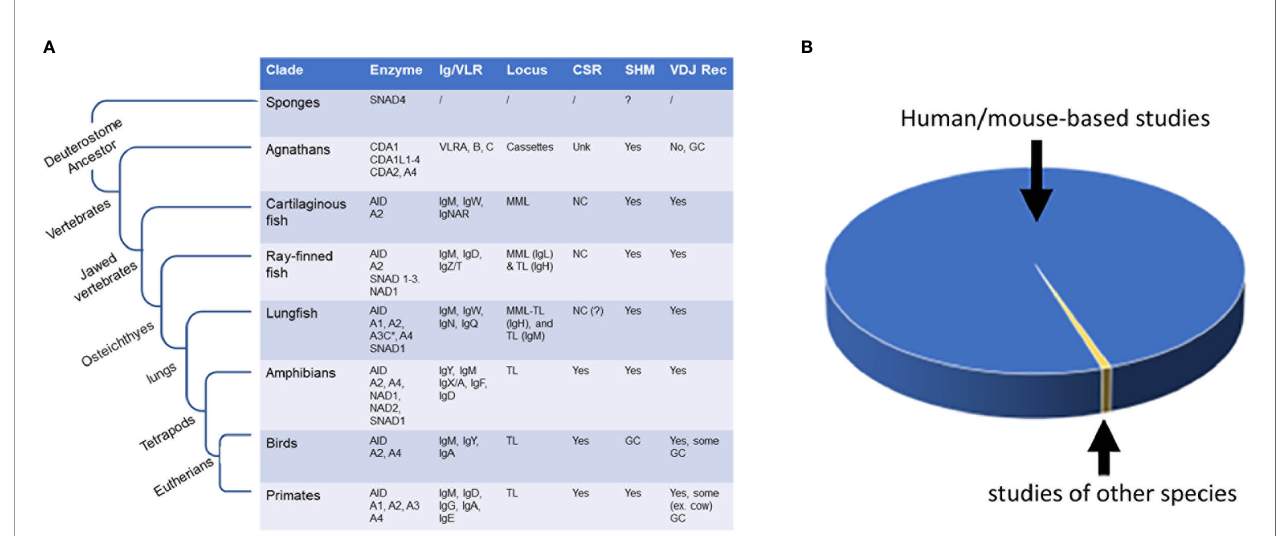
FIGURE 1 | Evolutionary and evolutionary comparative studies of AID/APOBEC and AID/APOBEC-like enzymes. (A) The emergence of AID/APOBEC and AID/ APOBEC-like enzymes during evolution and the evolution of antibody genes (Ig/VLR), and occurrence of secondary antibody diversi fi cation (i.e., antibody maturation; SHM and CSR) and primary antibody diversi fi cation (i.e., V[D]J recombination) within and outside of vertebrate class. (B) Comparison of number of reports examining AID inhuman and mouse (blue; > 99%) andstudies doneonother species (yellow;< 0.7%).The totalnumber of published peer-reviewed studies on AID as measuredby AID being a keyword in title/abstract (pubmed/scopussearch) is2368. Of these, 49 discussed the topicof AID inspecies other than human or mice (15 – 63) and17 (0.7%) presentedexperimental data examiningevolutionary divergent AID orthologs (17, 20, 21 26, 30 – 33, 39, 42, 45, 47, 52, 56, 61 – 63). NC, noncanonical;MML,multiplemini loci; TL,translocon;GC, Gene conversion (orGene conversion-like); unk,